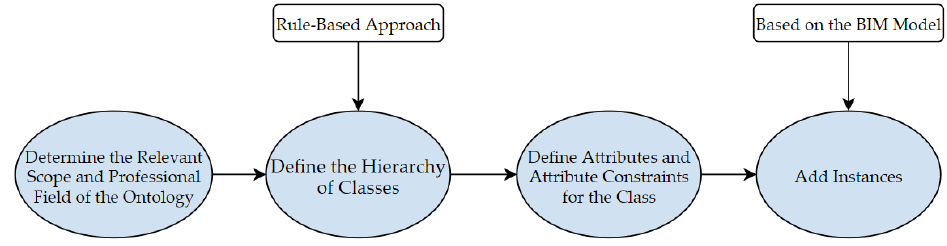
Figure 3. The ontology-modeling process of the construction safety risk knowledge base.